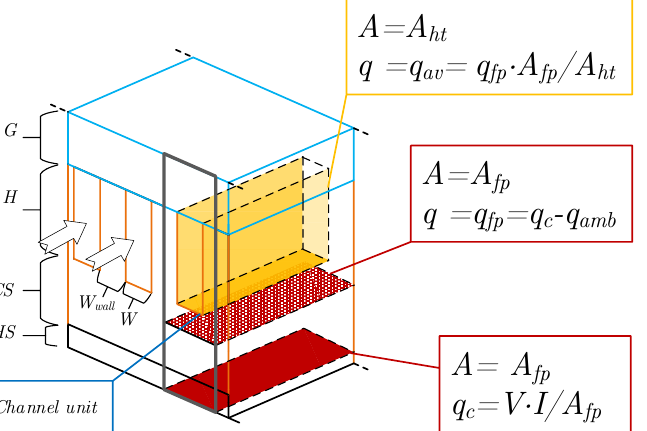
Figure 4. Schematic representation of the definition of heat transfer areas and heat fluxes for a single channel unit. HS = Heater + Solder, CS = Copper substrate, H = Channel height, G = Cover